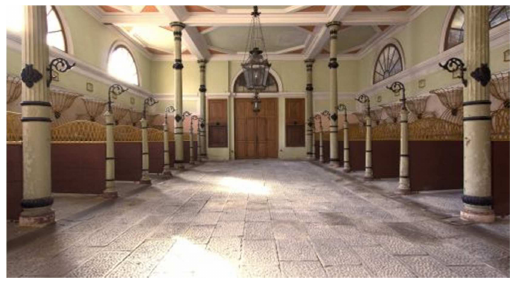
Figure 4: The stables.